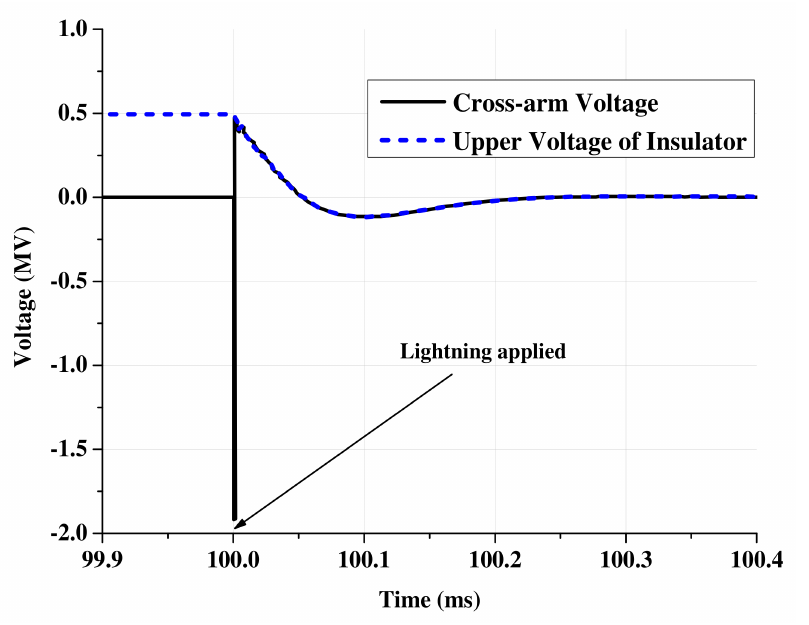
Figure 14. Voltage at tower cross-arm point and upper point of insulator with 100 kA lightning